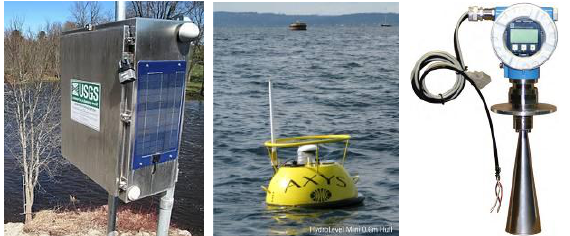
Figure 3: Common gauging systems: gauging station (USGS), GPS buoy (AXYS technologies) and radar level sensor (USGS).